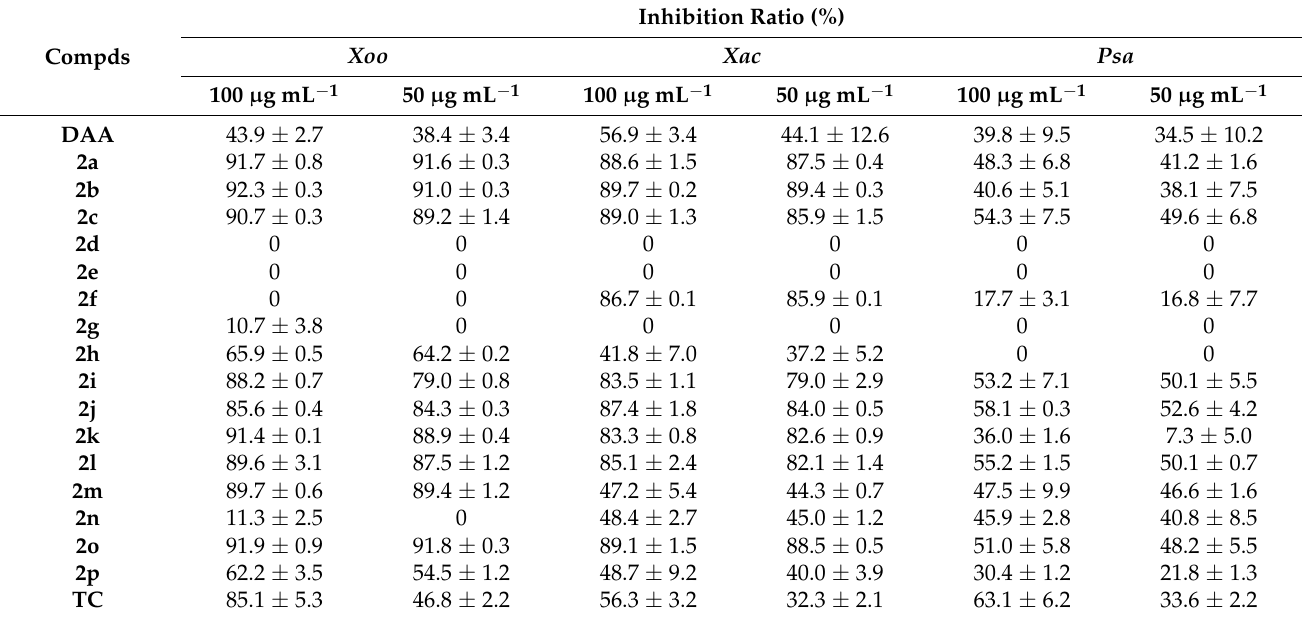
Table 1. Antibacterial bioactivity of compounds against the phytopathogenic bacteria Xoo , Xac , and Psa in